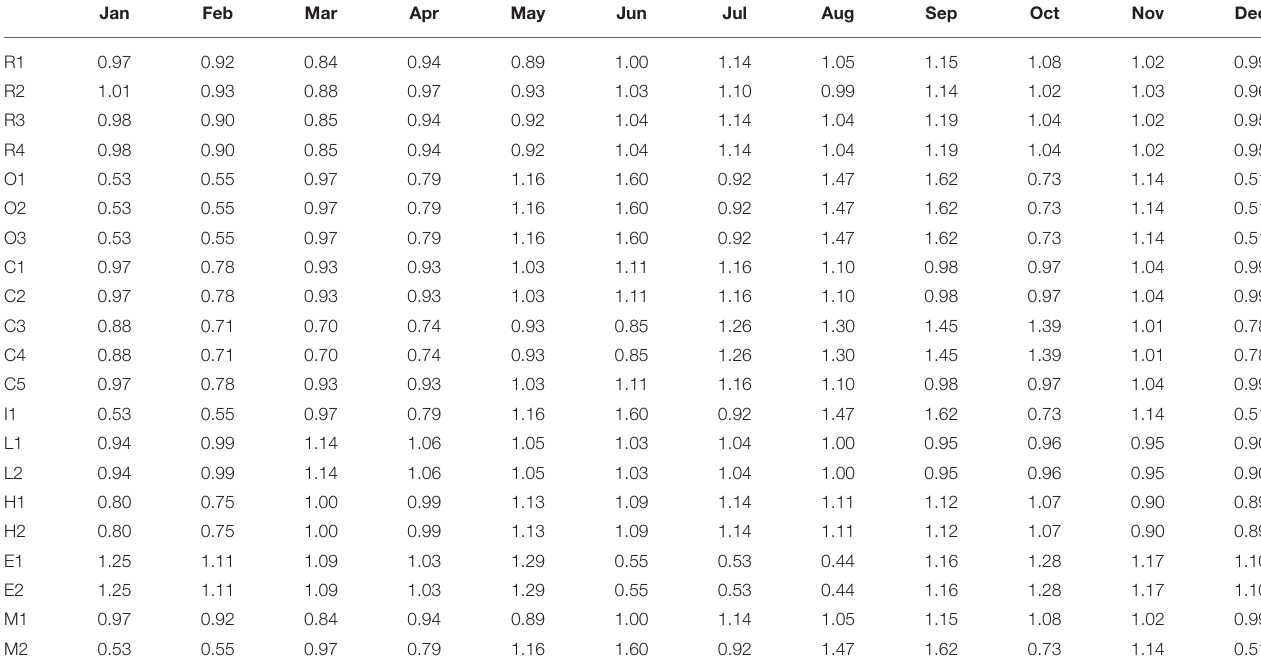
TABLE 3 | Monthly coefficients for all the 21 building types (average of all the 12-month coefficients for each building equals 1). Jan